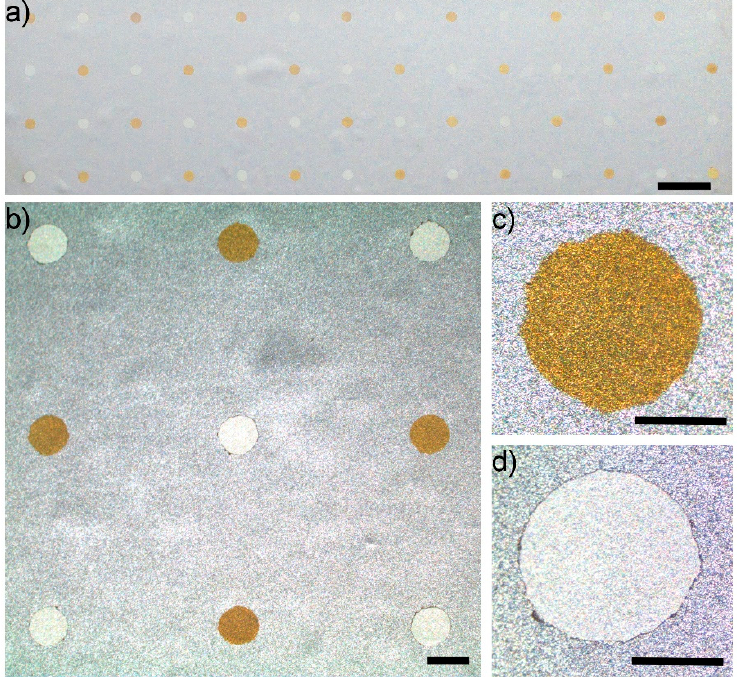
Figure 4. Parallel electrodeposition of gold and silver in the shape of circles on a nickel-coated substrate: ( a ) an array of 4 × 14 alternate dots (scale bar = 5 mm); ( b ) a microscope image of patterns (scale bar = 1 mm); ( c , d ) a microscope image of a deposited layer of (c) gold and (d) silver (scale bar = 0.5 mm).